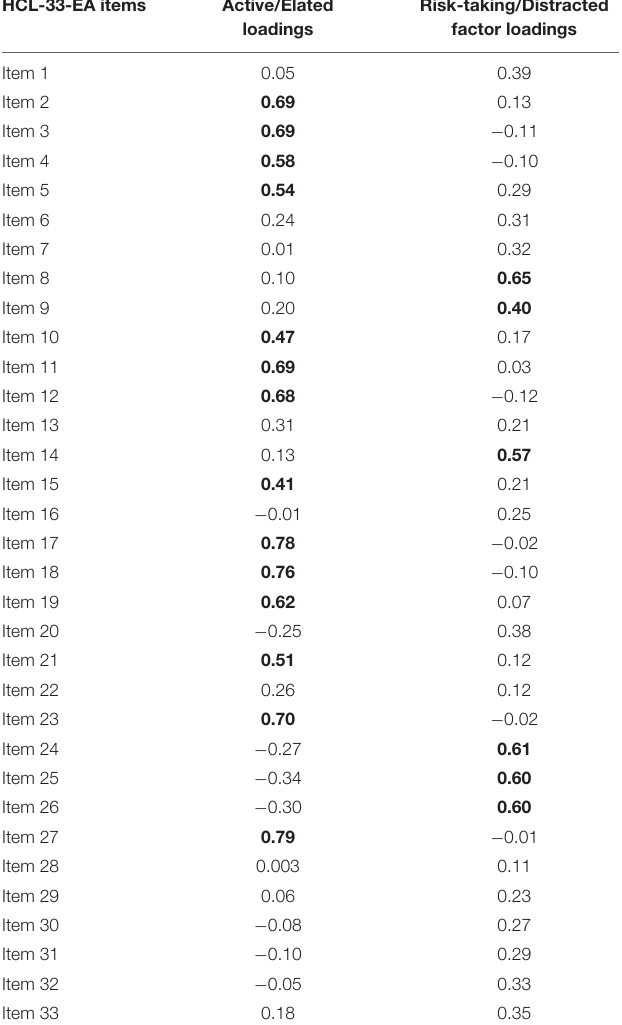
TABLE 4 | Factor loadings of the HCL-33-EA in adolescents with mood disorders ( n =